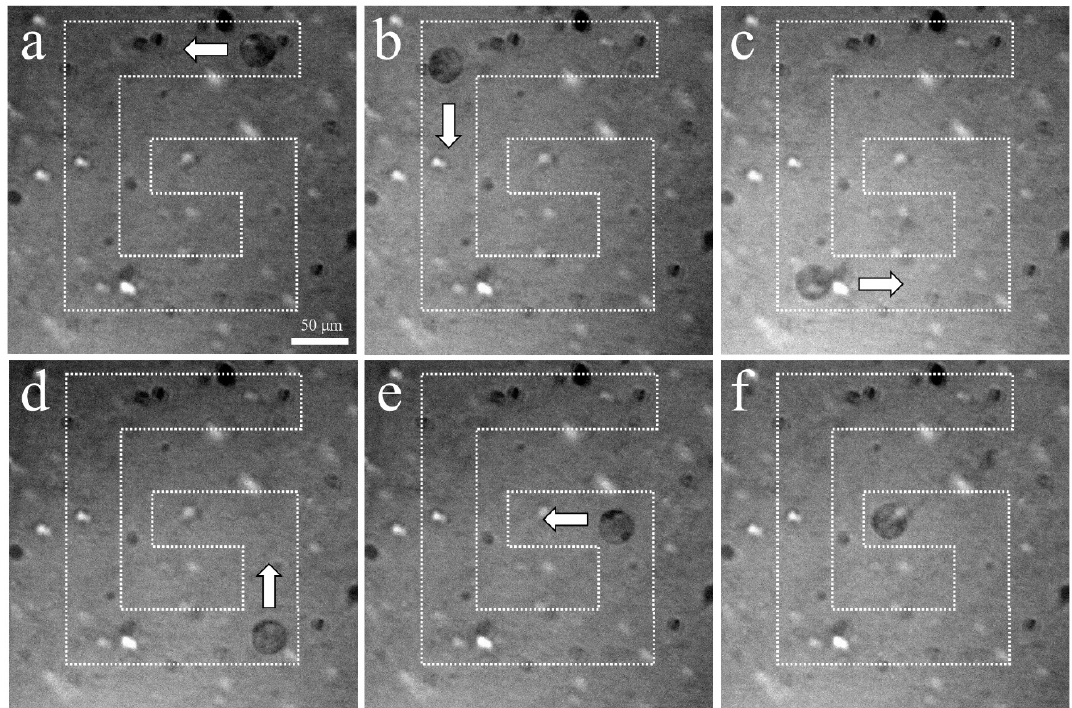
Figure 11. Microscopic photographs of a single PC-3 trapping using a 410 MHz transducer: ( a – f ) show the movement of a cell along the SBAT direction. The white arrow represents the direction of transducer movements. PC-3 is moved through a “G” pattern. Scale bars indicate 50 μ m.